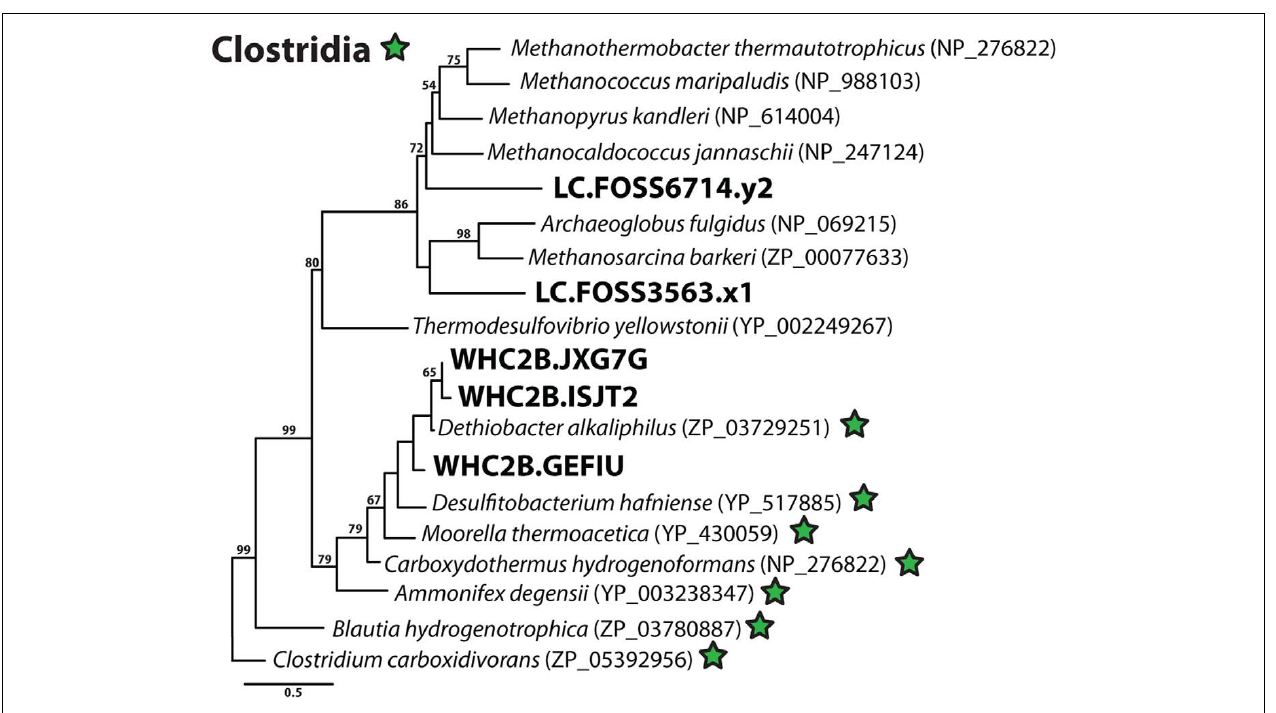
green stars, and Lost City (LC), andTablelands (WHC2b) sequences are in large, bold font. Maximum-likelihood bootstrap support values > 50 are